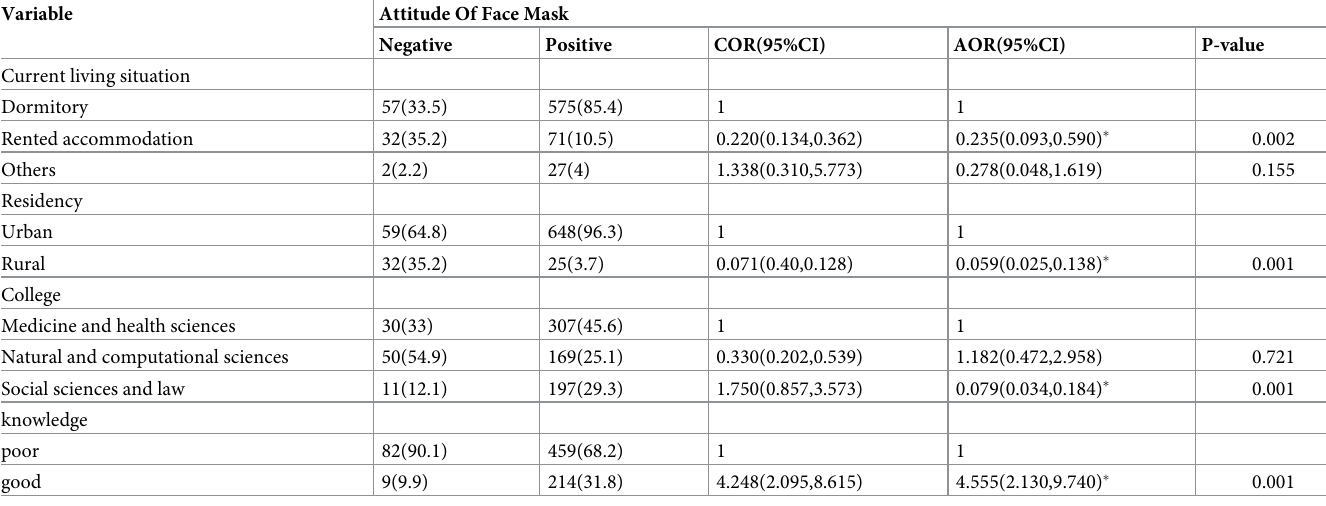
Table 6. Factors affecting attitude of the respondents on knowledge, attitudes, and practices of face mask utilization and associated factors in COVID-19 pandemic among Wachemo university students, southern Ethiopia: February to March 2021 (n = 764).